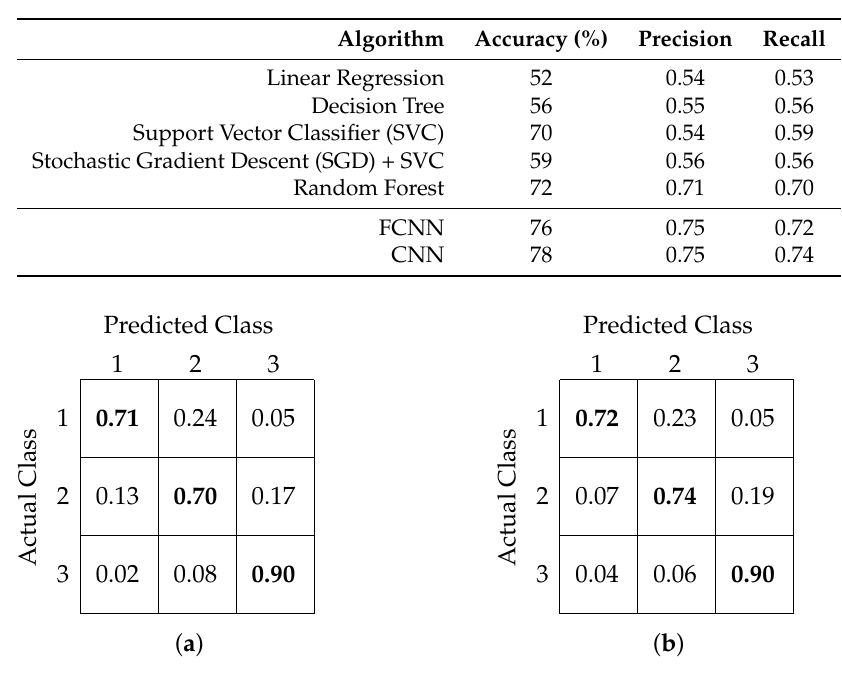
Figure 11. Confusion matrix for 3-class classification using ( a ) FCNN-based architecture and ( b ) CNN-based